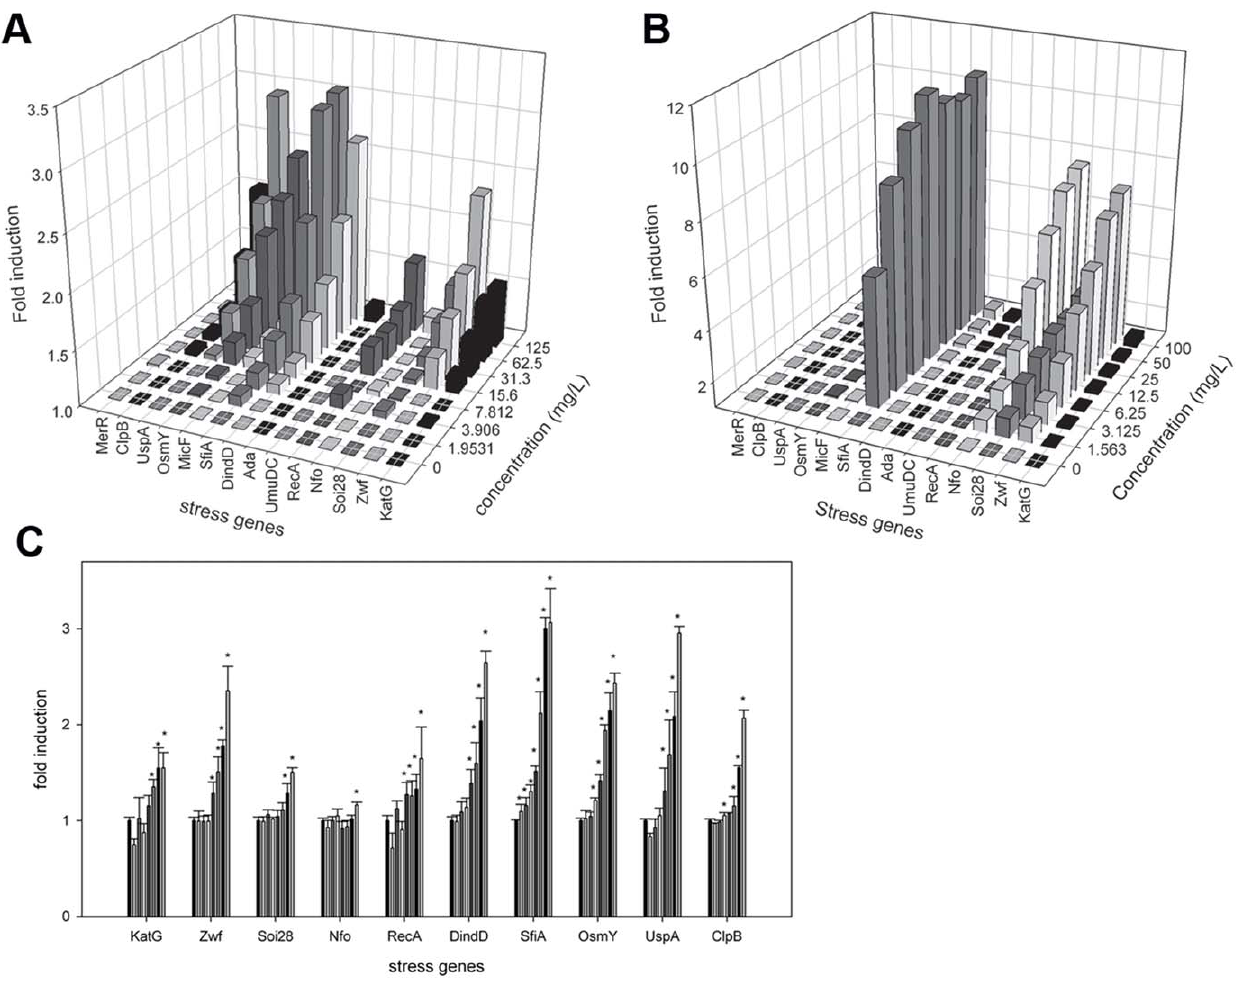
Figure 3. Bacterial dose response profile after exposure to an adjuvant (ethoxylated nonylphenol) and a reference compound (paraquat). Figure 3a) ethoxylated nonylphenol, and 3b) paraquat. The y-axis denotes the induction at any given dose, the x-axis shows the different stress genes and the z-axis shows the applied concentrations in a K serial dilution. All data are means of three replicates (n=3), c) Detailed results for significantly induced genes after exposure to ethoxylated nonylphenol meeting the criteria as mentioned in Material and Methods, bars indicate standard error. *Significantly different from solvent control (one-way ANOVA, Dunett’s test, p , 0.05).